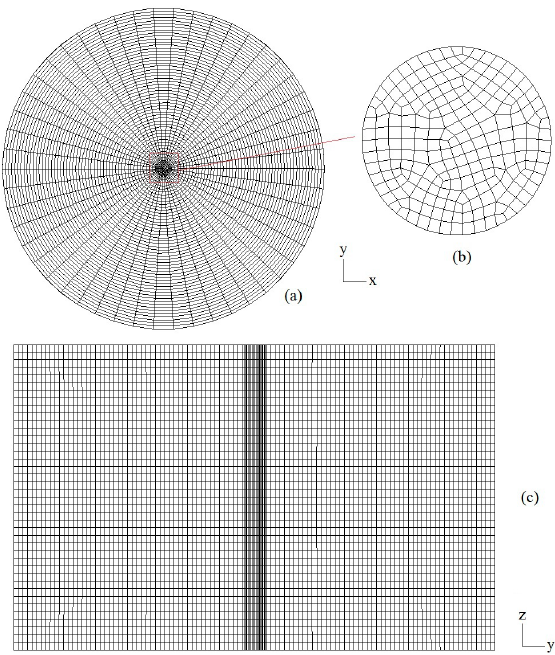
Figure 4. Grid used in the computational fluid dynamics (CFD) simulations: ( a ) bottom, ( b ) inlet, and ( c ) axial cross-section.